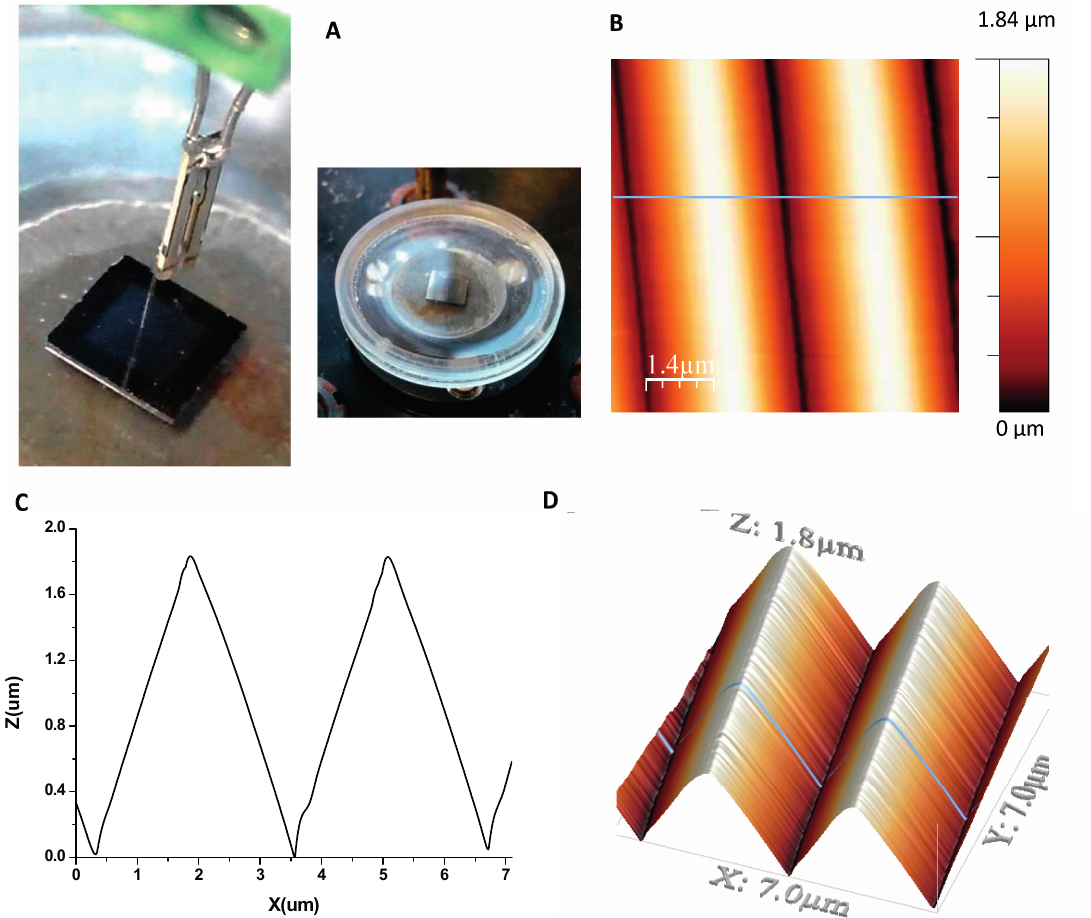
Figure 4. ( A ) Measurement set-up. The QTF probe is immersed in buffer solution to access the sample using a liquid cell; ( B ) Shear force image of the TGG01 3 μ m pyramidal calibration grating. Image size is 7 μ m × 7 μ m; The topographic profile of 1024 p. and the same image rendered in 3D are shown in ( C ) and ( D )